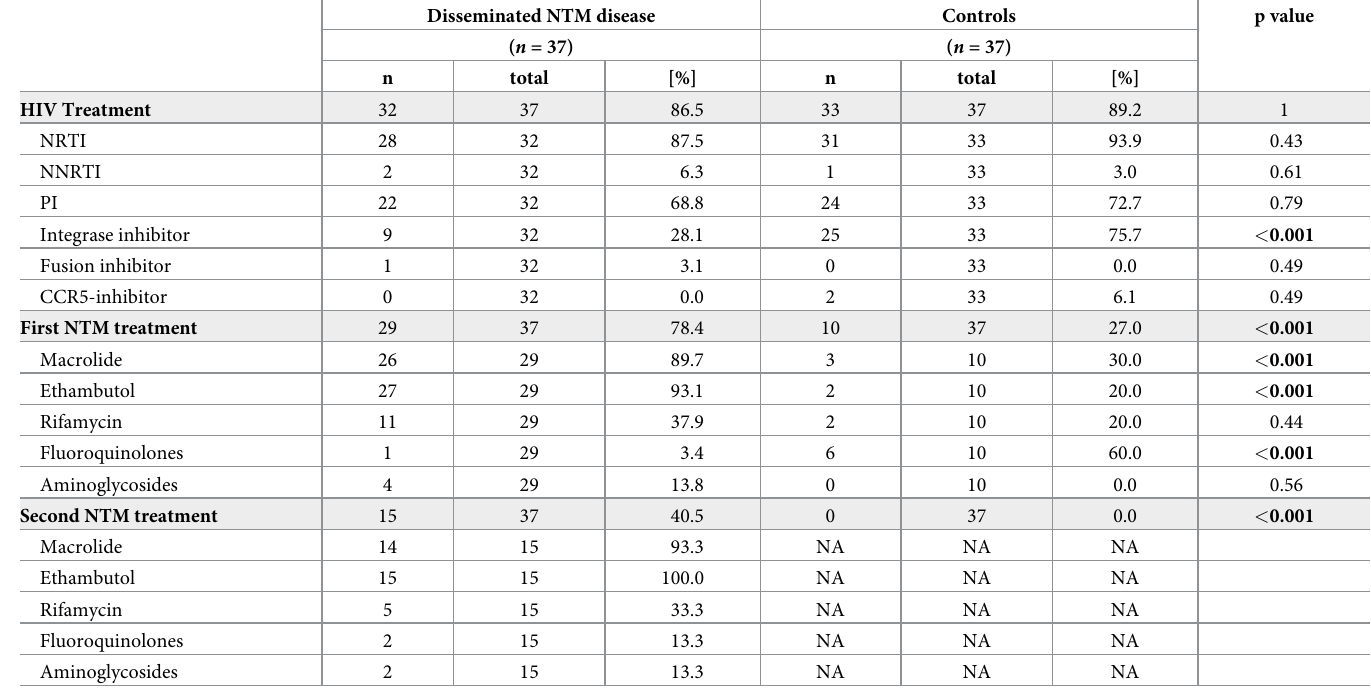
Table 4. Antiretroviral and antimycobacterial treatment in the case group and